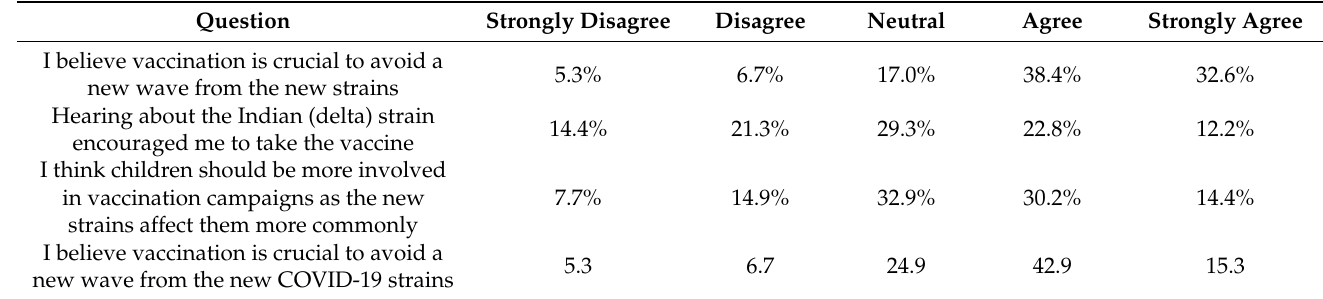
Table 4. Attitudes towards recent issues in